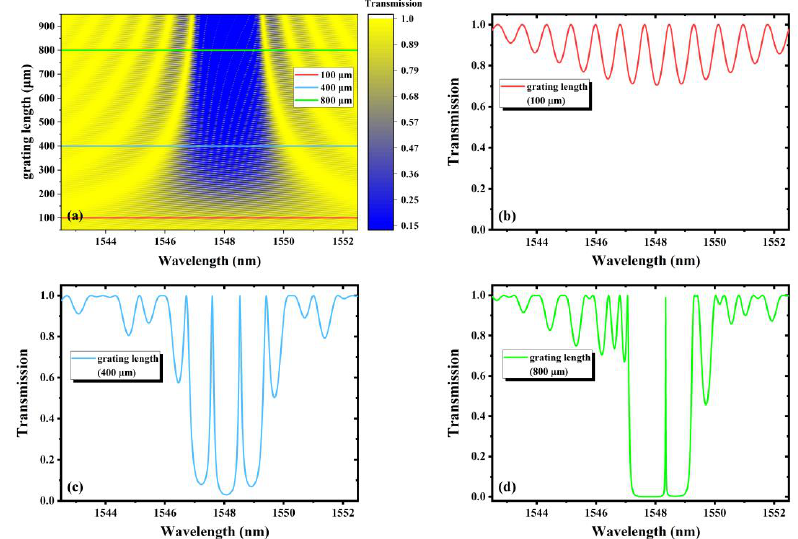
Figure 3. ( a ) The transmission spectra with continuous variation of grating length from 50 μm to 950 μm ; the transmission spectra with grating length of ( b ) 100 μm, ( c ) 400 μm and ( d ) 800 μm.